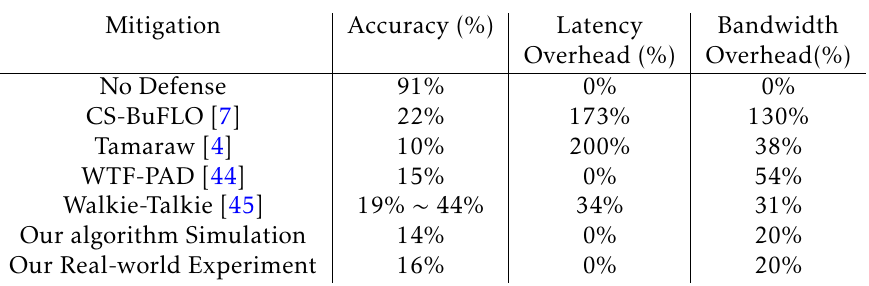
Table 4. Comparison of our algorithm’s accuracy and overhead with previous mitigation schemes. We showed the lowest accuracy numbers for the other schemes, regardless of algorithms used. The table is based from [44].